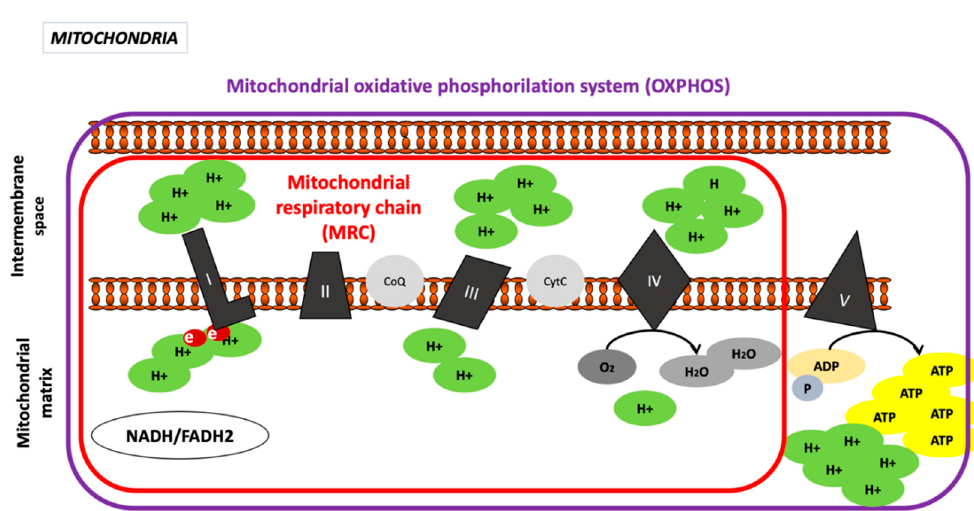
Figure 2. Mitochondrial respiratory chain and oxidative phosphorylation system in the mitochondria. ADP, adenosine diphosphate; ATP, adenosine triphosphate; I, complex I; II, complex II; III, complex III; IV, complex IV; V, complex V; CoQ, coenzyme Q; CytC, cytochrome C; e, electrons; FADH, flavin and adenine dinucleotide; H+, proton; NADH, nicotinamide adenine dinucleotide hydrogen and OXPHOS, oxidative phosphorylation system.